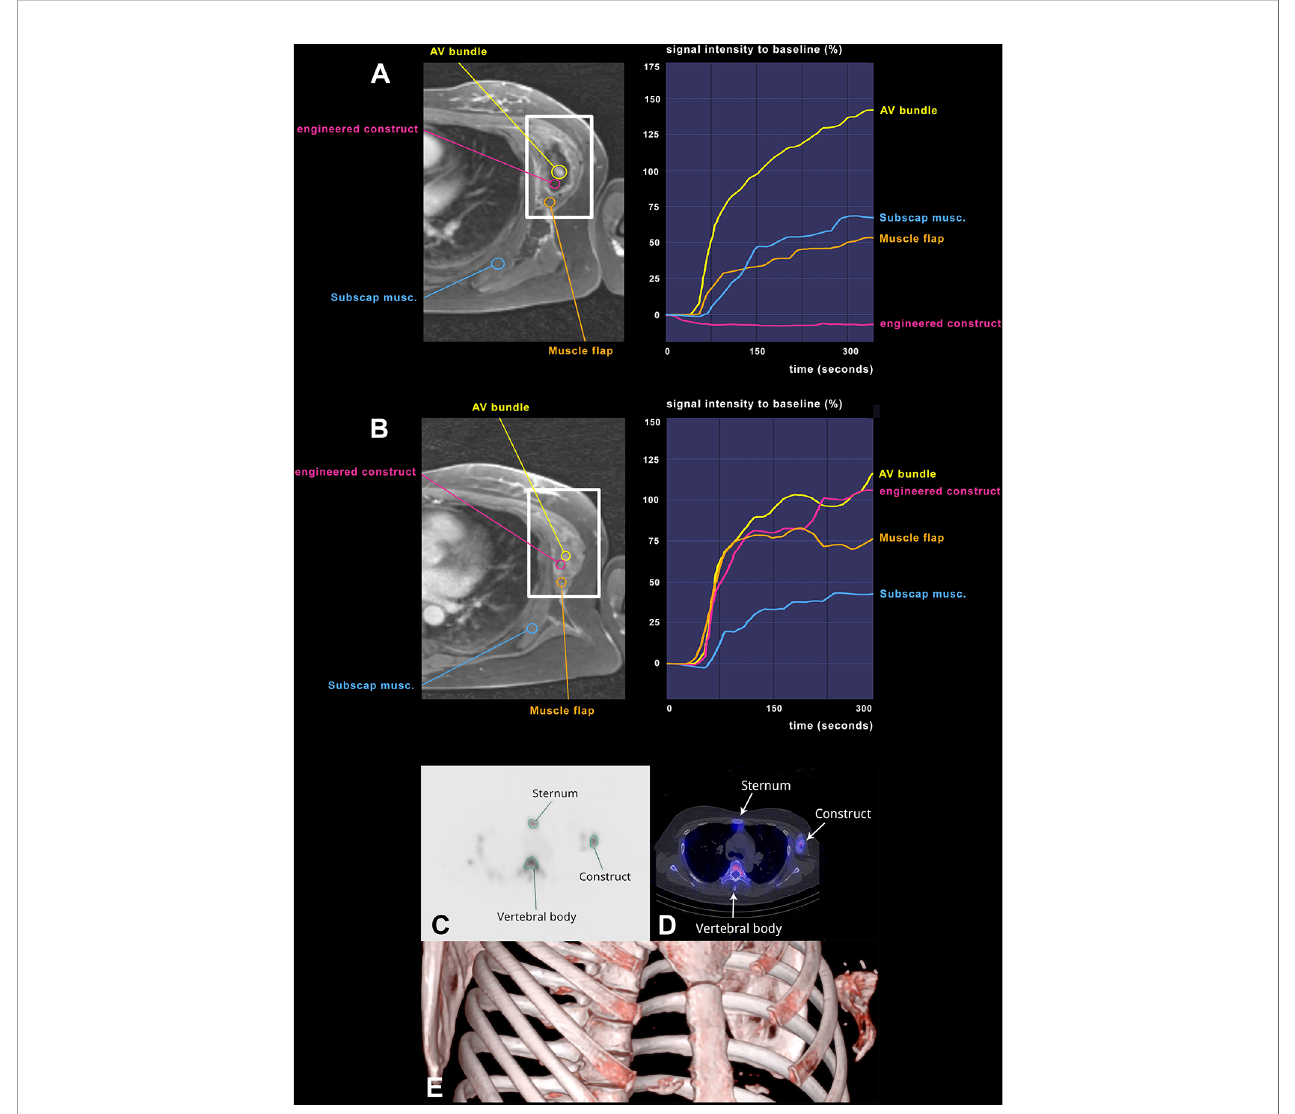
FIGURE 3 | Longitudinal assessment of vascularization and bone formation. Transversal images of a golden-angle radial sparse parallel (GRASP) MRI showing the perfusion of the engineered construct adjacent to the left ribcage over time as well as corresponding signal-time curves at 1 week (A) and at 6 weeks (B) . The Maxilla construct is highlighted by white rectangles. Signal intensity in relation to t = 0 (injection of contrast agent) on the Y-axis, time in seconds on the X-axis. Violet region of interest (ROI) located in the construct, blue ROI located in the left M. subscapularis in situ and yellow ROI encompassing the AV bundle. Orange ROI indicates M. latissimus dorsi fl ap covering the construct. M. subscapularis was used as a reference for physiological vascularization in this area. Planar images (C) and SPECT and SPECT/CT images (D) after 6 weeks of the bone scintigraphy, showing strong DPD uptake in the construct, indicating bone turnover and vitality of the construct. In a region-of-interest (ROI) analysis of the maxilla construct at its largest diameter in comparison to the sternum (as a bone with similar structure/size). (E) VRT (volume rendering technique) from the SPECT illustrates the location of the prefabricated